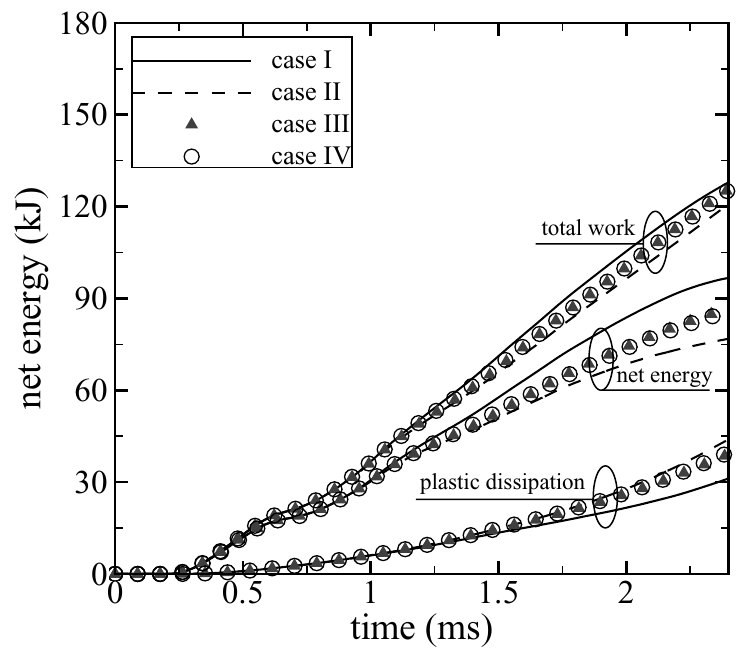
Fig. 19. Influence of the bonding sequence on the net energy transferred to the